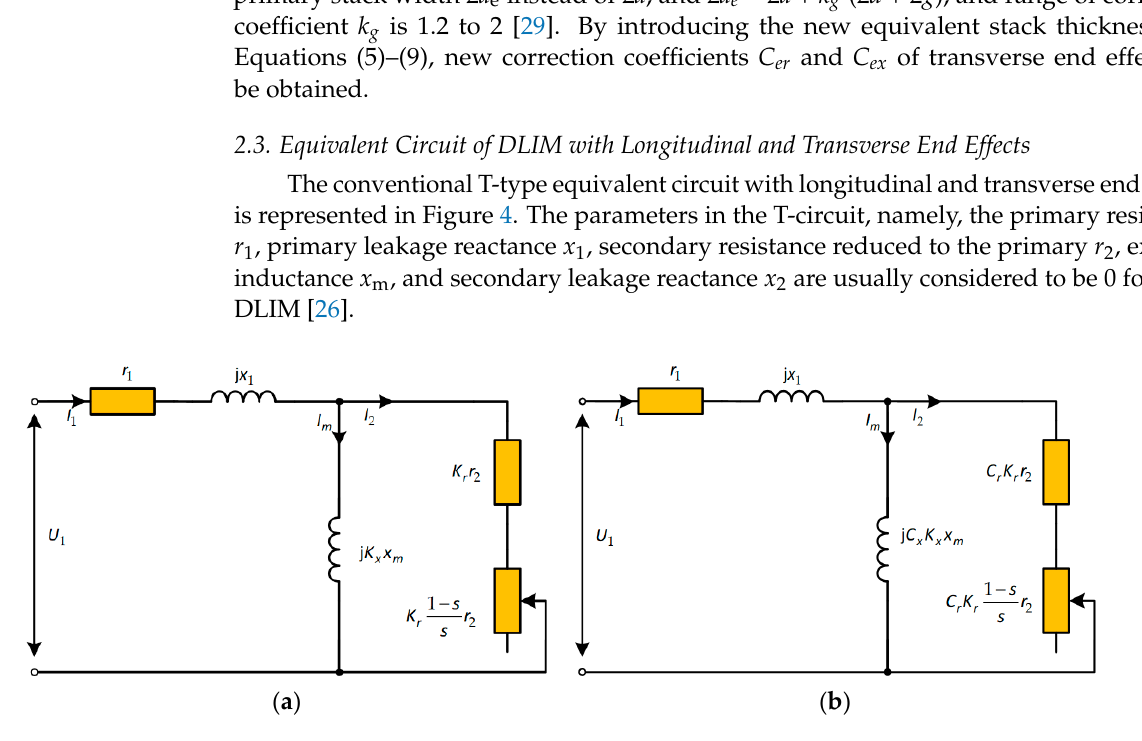
Figure 4. Equivalent circuit of DLIM: ( a ) only longitudinal end effect considered (EC-L); ( b ) both longitudinal and transverse end effect considered (EC-LT).